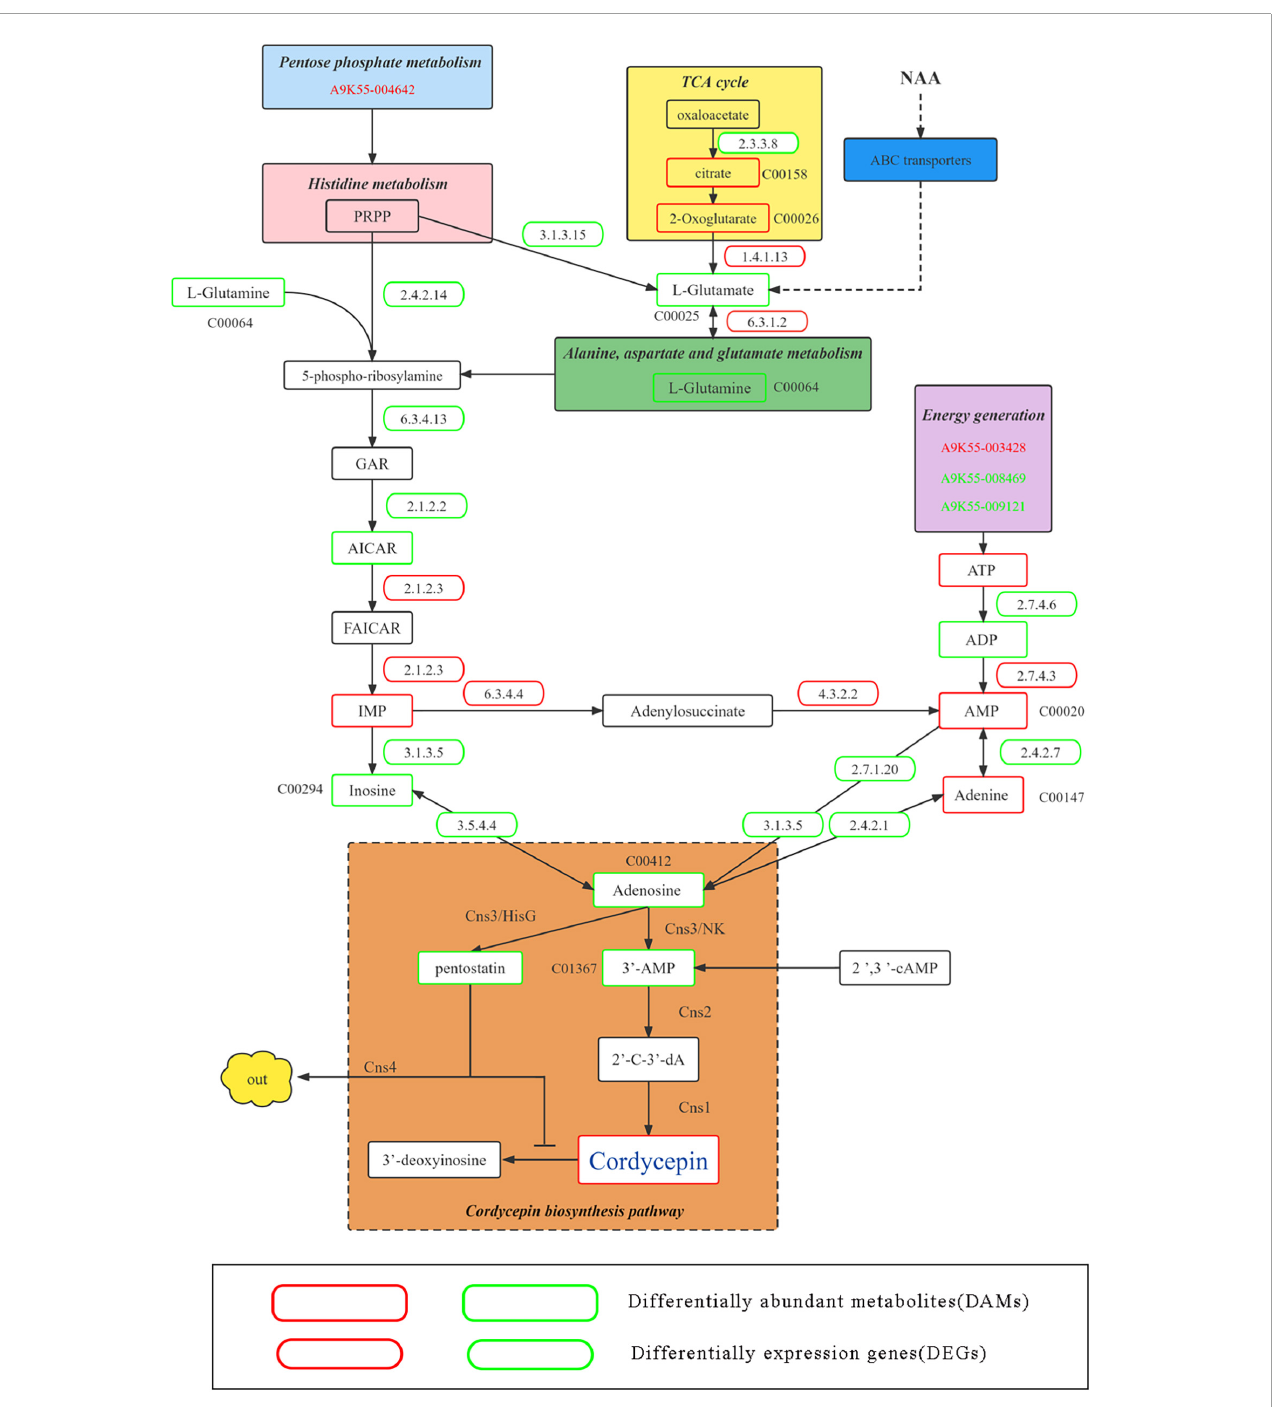
FIGURE7 Putative pathway of cordycepin metabolism and synthesis. Green and red boxes represent downregulated and upregulated genes and metabolism and synthesis. Green and red gene numbers represent downregulated and upregulated genes, respectively.